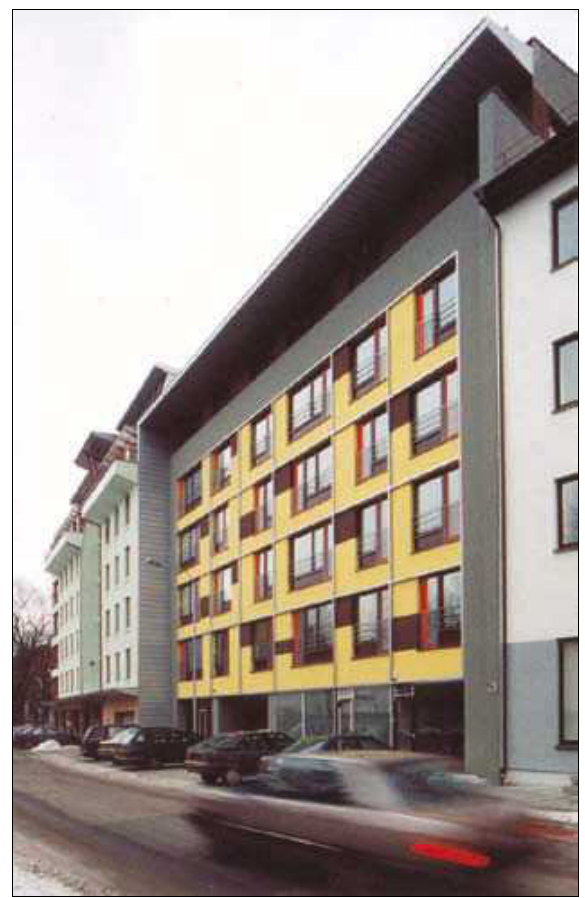
7 pav. Dau­giabu­tis namas su­ įstaigomis Sierakau­sko g. (archit. G. Čaikau­skas, r­. Palekas) Fig. 7. block of flats with offices in Sierakau­skas st. a­rch. G. Čaikau­skas, r­.